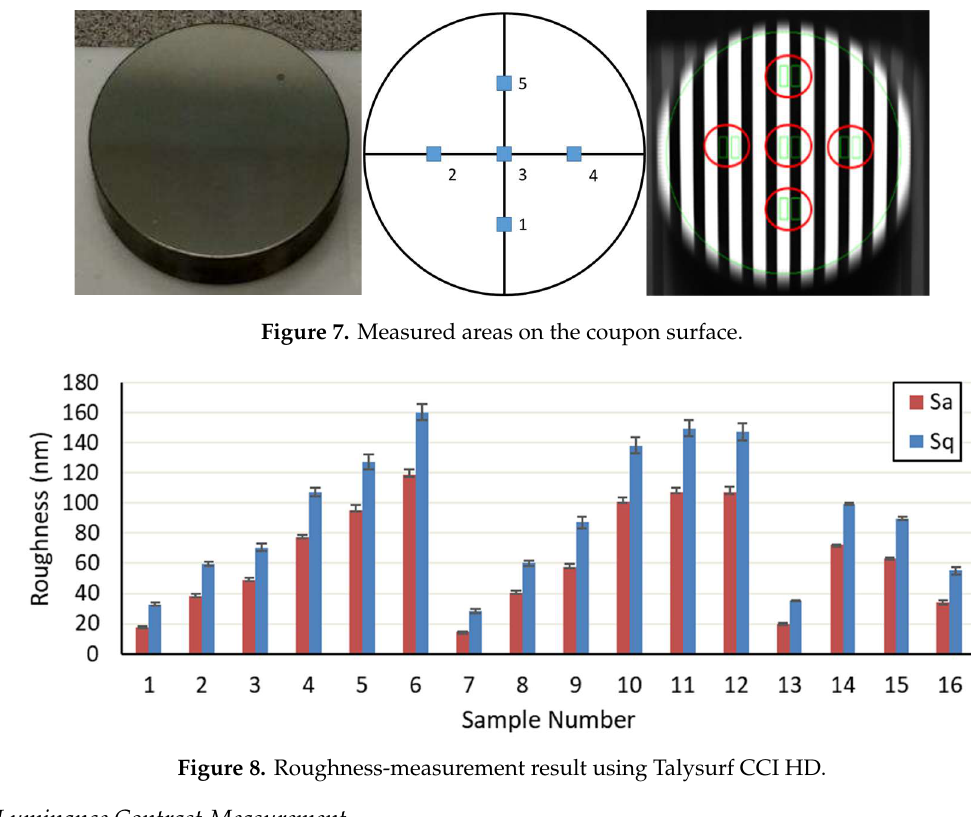
Figure 8. Roughness-measurement result using Talysurf CCI HD.